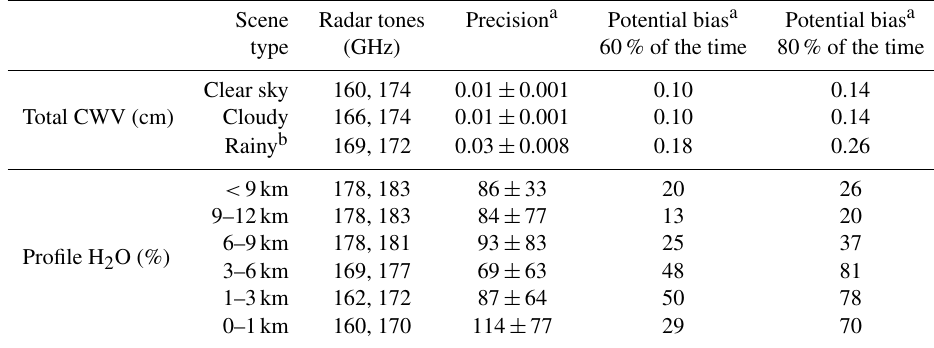
Table 3. Optimum radar tones